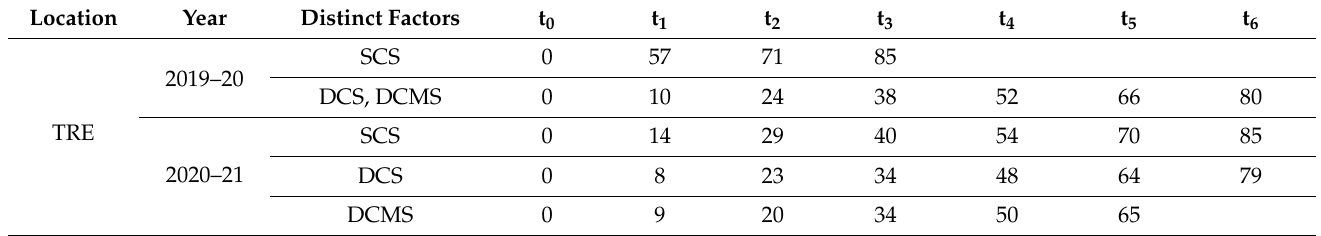
Table A1. Measurement dates (t i ) in days after sowing (DAS, d) for each treatment. (TRE = Trenthorst, NEB = Neu-Eichenberg; SCS = sole cropped system, DCS = double cropping system, DCMS =